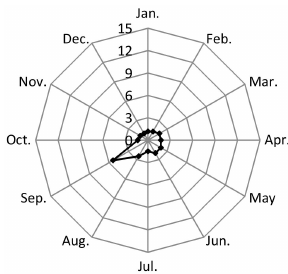
Figure 2. Temporal distribution in the basin of the Yarlung Zangbo River.